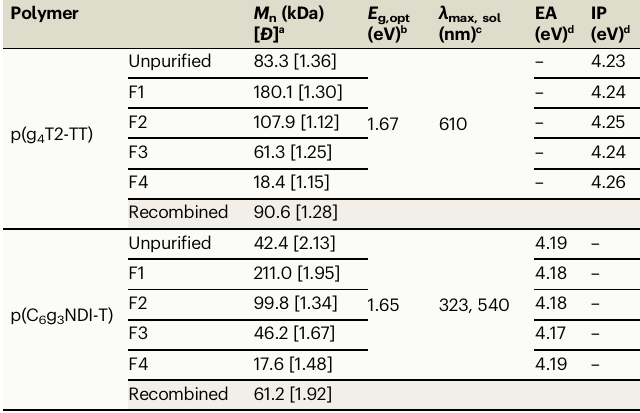
Table 1 | Summary of the two polymer series ’ physical and